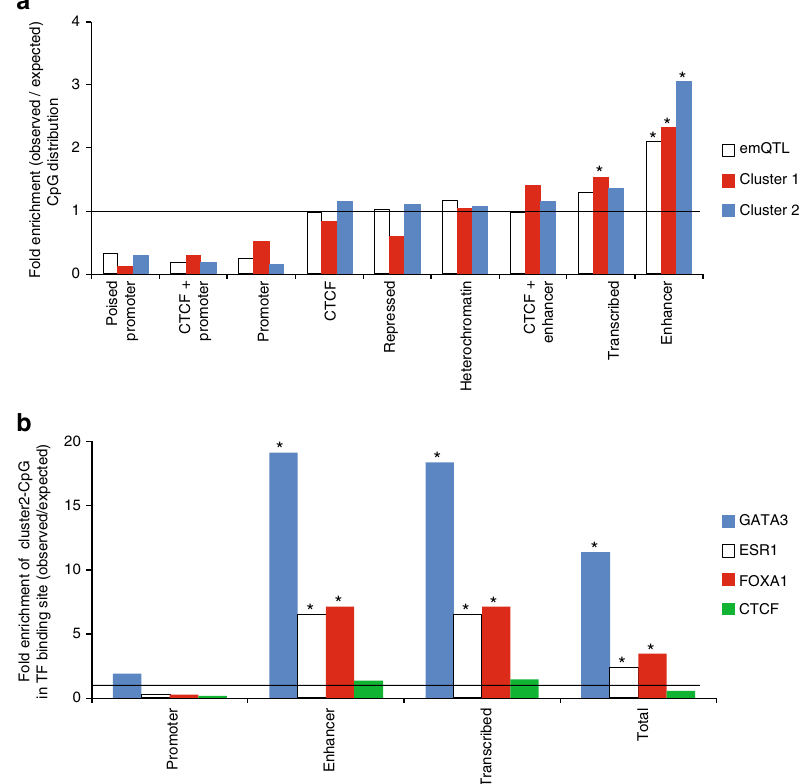
Fig. 2 Genomic location of emQTL-CpGs according to ChromHMM and TF binding regions a Bar plot showing the enrichment of emQTL, Cluster 1 and Cluster 2 CpGs over the expected frequency of CpGs from the Illumina HumanMethylation450 across functional/regulatory regions of the genome as determined by MCF7 ChromHMM annotation 62 . The height of the bars represents the level of enrichment measured as a ratio between the frequency of all emQTL-CpGs ( white ), CpGs in Cluster 1 ( red ) and CpGs in Cluster 2 ( blue ) overlapping a functional element over the expected frequency if such overlaps were to occur at random. Statistically signi fi cant enrichments ( p < 0.05; hypergeometric test) are marked with an asterisk. b Enrichment analysis of CpGs in Cluster 2 across ER α ( white ), GATA3 ( blue ), FOXA1 ( red ) and CTCF ( green ) binding regions as determined by ChIP-seq analysis. Enrichment is calculated for different genomic regions determined by MCF7 ChromHMM annotation. For this analysis some ChromHMM annotations were collapsed into one as follow: Enhancer = ‘ Enhancer ’ and ‘ Enhancer + CTCF ’ and Promoter = ‘ Promoter ’ , ‘ Promoter + CTCF ’ and ‘ Poised Promoter ’ . The height of the bars represents the level of enrichment measured as a ratio between the frequencies of CpGs in Cluster 2 in each ChIP-seq peak at speci fi c regulatory region over the expected frequency if such overlaps were to occur at random. Statistically signi fi cant ( p < 0.05; hypergeometric test) enrichments are marked with an GREB1, FOS, DPF2, AHR, and ZNF217-binding regions (Supplementary Fig. 2B and Supplementary Data 1). To further